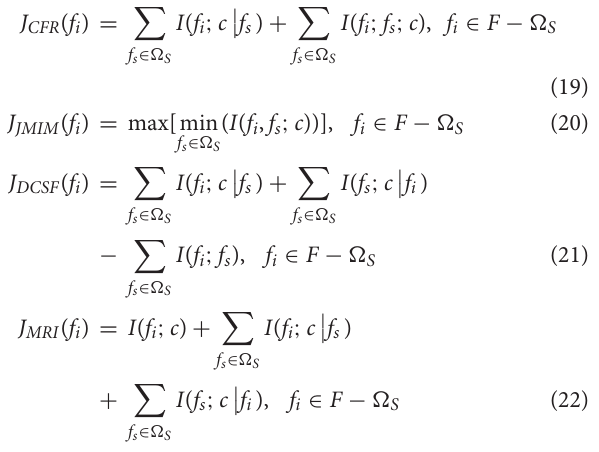
algorithm (DWFS), Interaction Weight based Gene selection algorithm (IWFS) and Redundancy Analysis and Interaction Weight-based gene selection algorithm (RAIW). All of